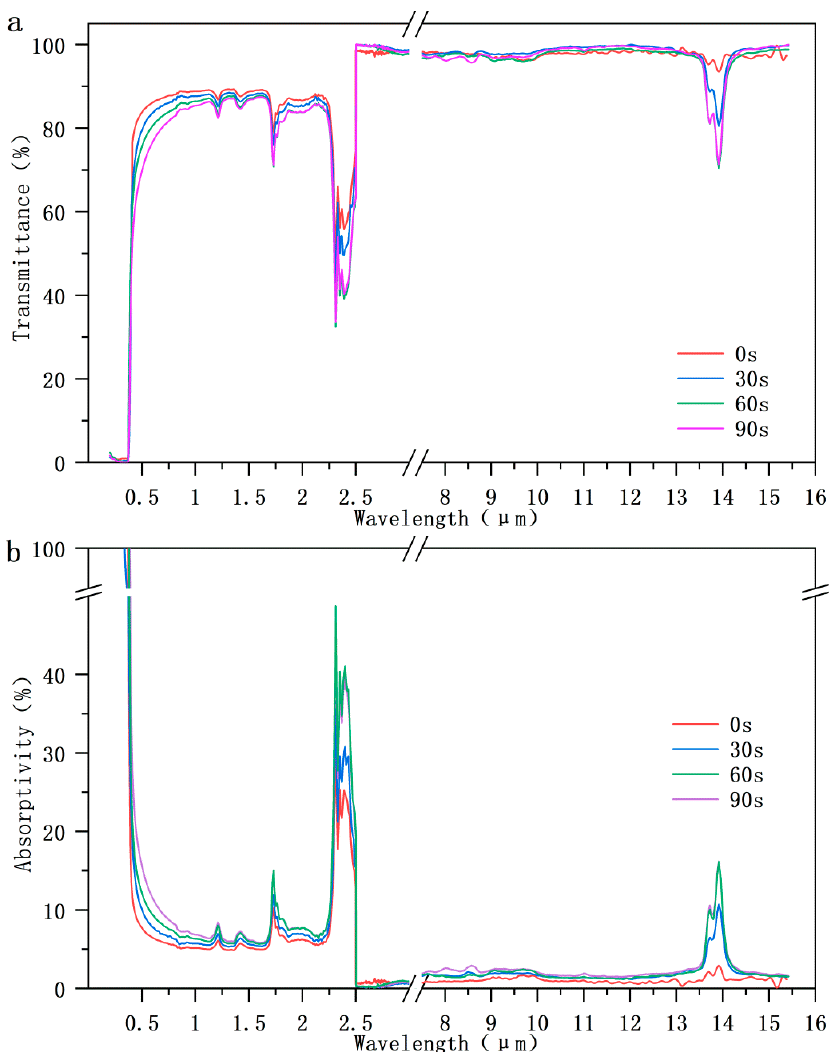
Figure 7. Optical properties of ZnO/LDPE films: ( a ) effect of plasma treatment time on film transmit- tance; and ( b ) effect of plasma-treatment time on film absorptivity. Table 1. Transmissivity and absorptivity of the films represented by the area under the FTIR curves.